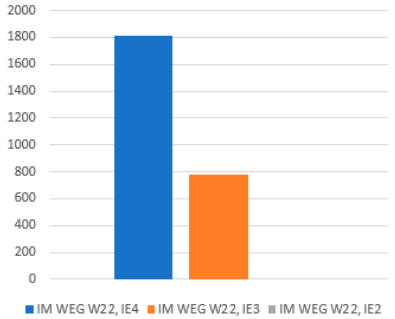
Figure 4. Annual energy consumption E y.m (MW · h).